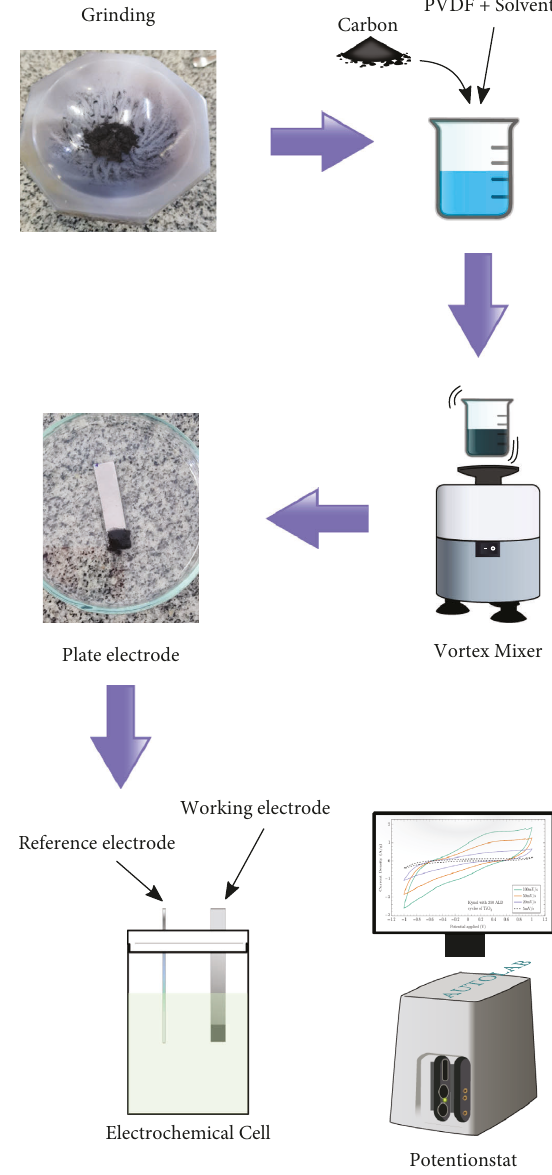
Figure 3: Schematic of the electrode assembly steps.